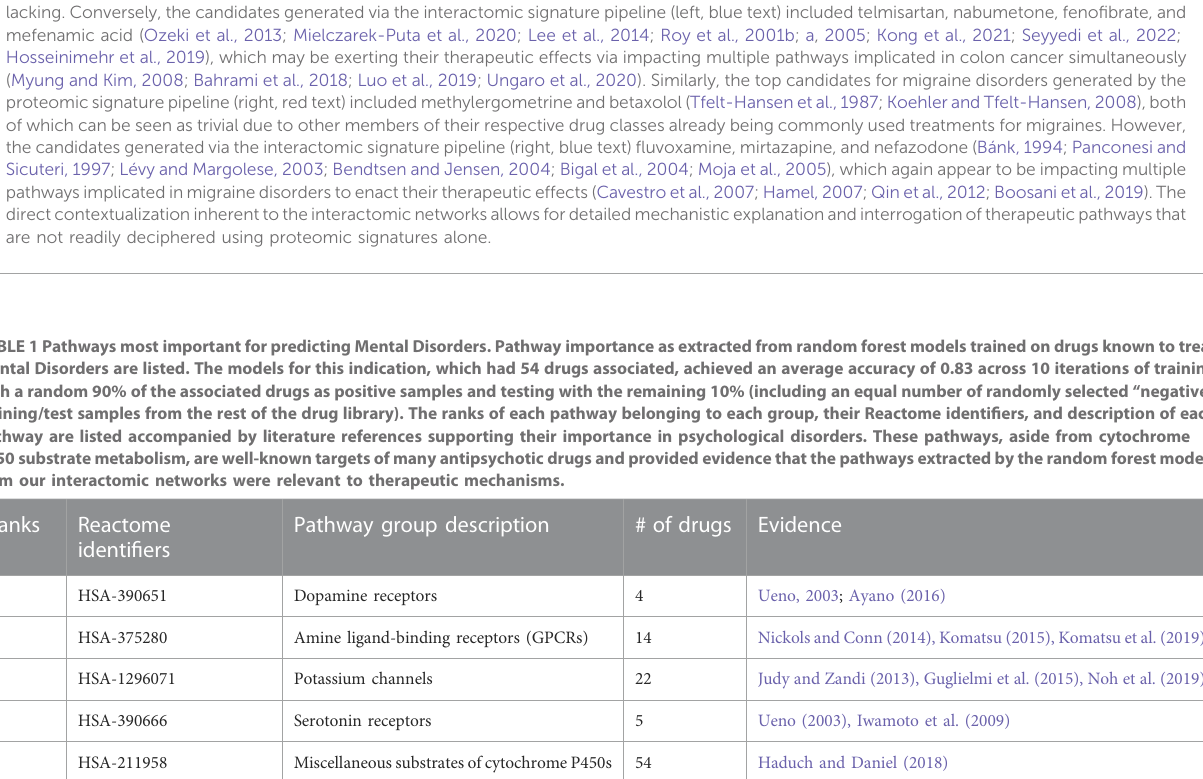
FIGURE 6 AnalysisofvalidationsgeneratedforcoloncancerandmigrainedisordersbymultiplepipelineswithintheCANDOplatform.Putativedrugcandidates were generated for Colonic Neoplasms (MeSH:D003110) and Migraine Disorders (MeSH:D008881) using the interactomic signatures as well as the control proteomic signatures. Candidates were generated using a consensus voting scheme (ection 4.7). For both indications, the pipeline using interactomicsignatures generated more candidates (blue text)that werecorroborated bystudies inthebiomedical literature thantheone basedon proteomic signatures (red text), while also providing mechanistic individual target and pathway information (shaded blue boxes). The top candidates for colon cancer generated using the proteomic signature pipeline (left, red text) included alpremilast and mebendazole (Nygren et al., 2013; Nygren and Larsson, 2014; Williamson et al., 2016; Nishi et al., 2017; Petersen and Baird, 2021), however mechanistic understanding using the whole signature